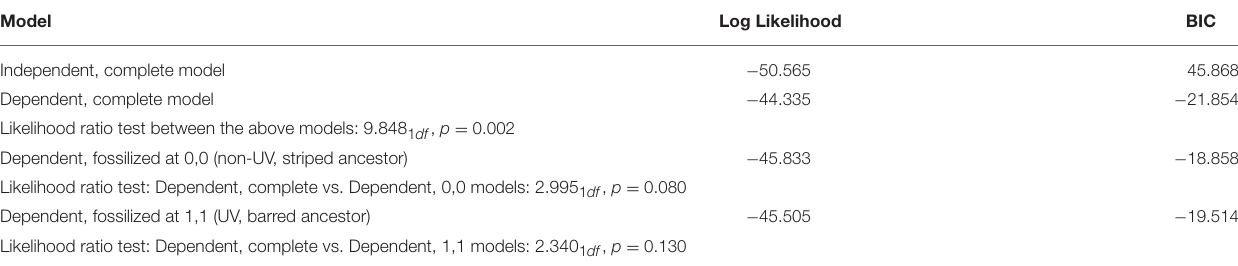
TABLE 5 | Model selection based on likelihood ratio tests and Bayesian Information Criteria (BIC).